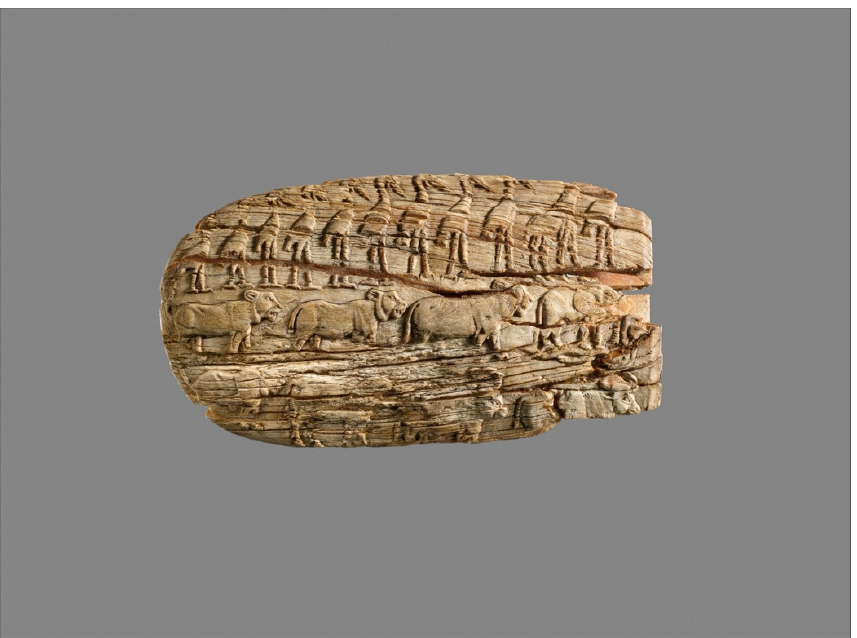
Figure 4. Carved handle of a ceremonial knife, ivory, possibly from Upper Egypt, Qau, ca. 3200 BCE. Purchase, Edward S. Harkness gift, 1926. Metropolitan Museum of Art, 26.7.1281. Public Domain.